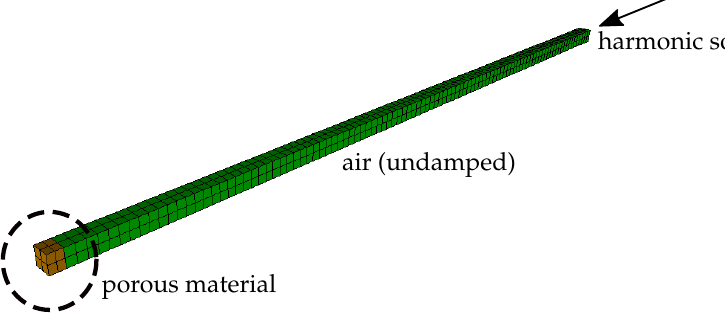
Figure A1. FEM-model of the impedance tube.